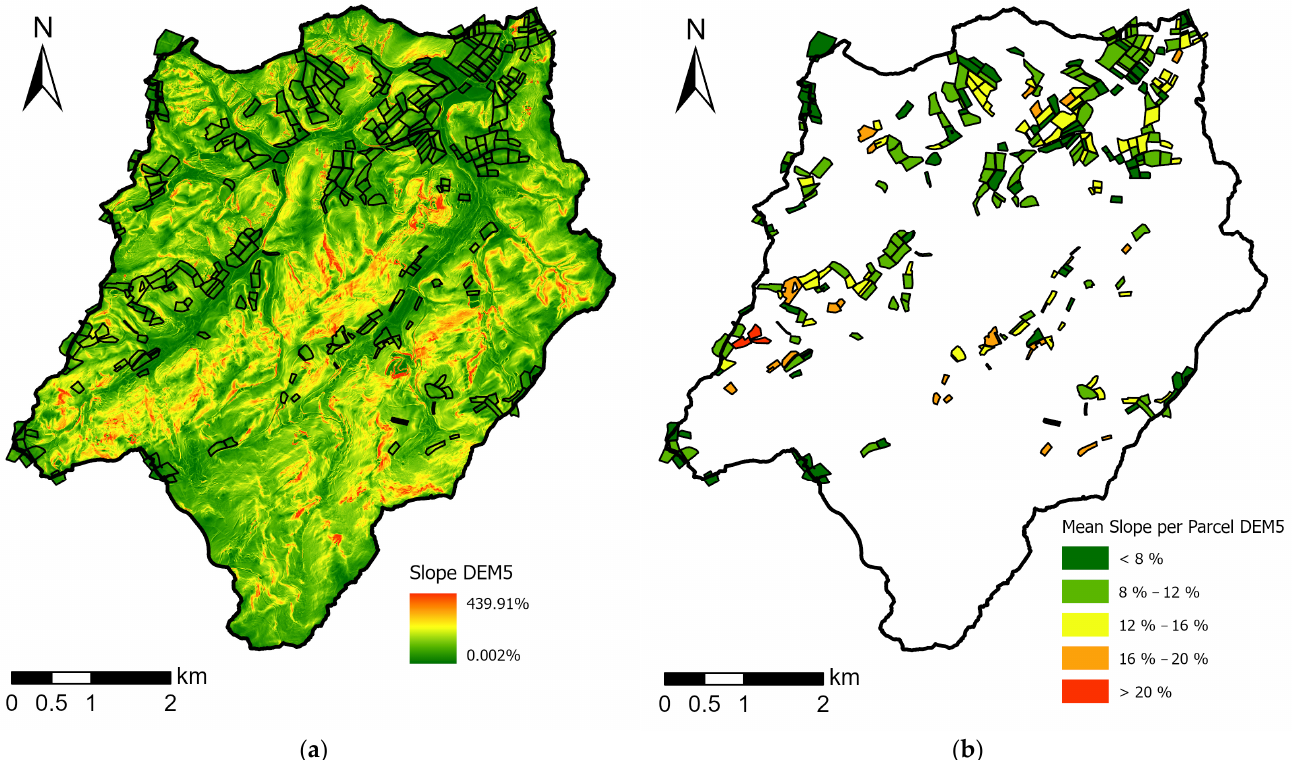
Figure 9. Slope in Fischbach catchment including area of arable land parcels under investigation: ( a ) Slope DEM5; ( b ) mean slope of DEM5 for masked arable land parcels following classification of ABAG for determining the P-factor; data source: [14,30,40].